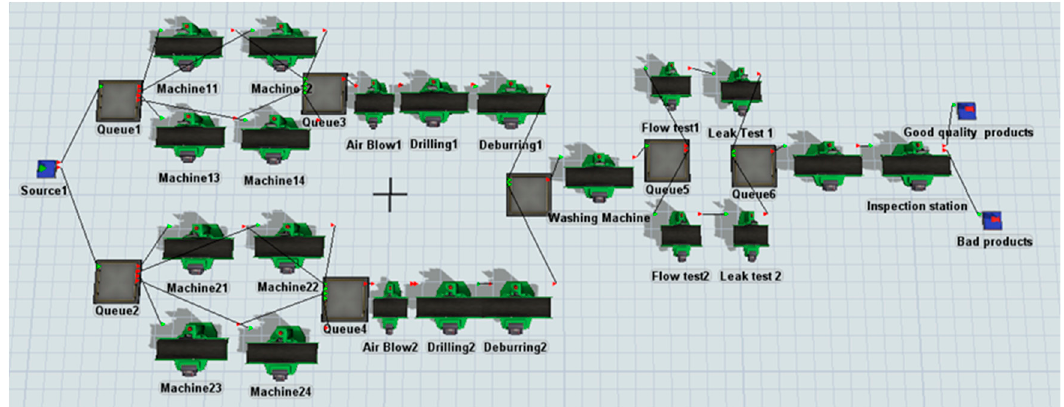
Figure 4. Reference model of the manufacturing line (Supplementary Materials).